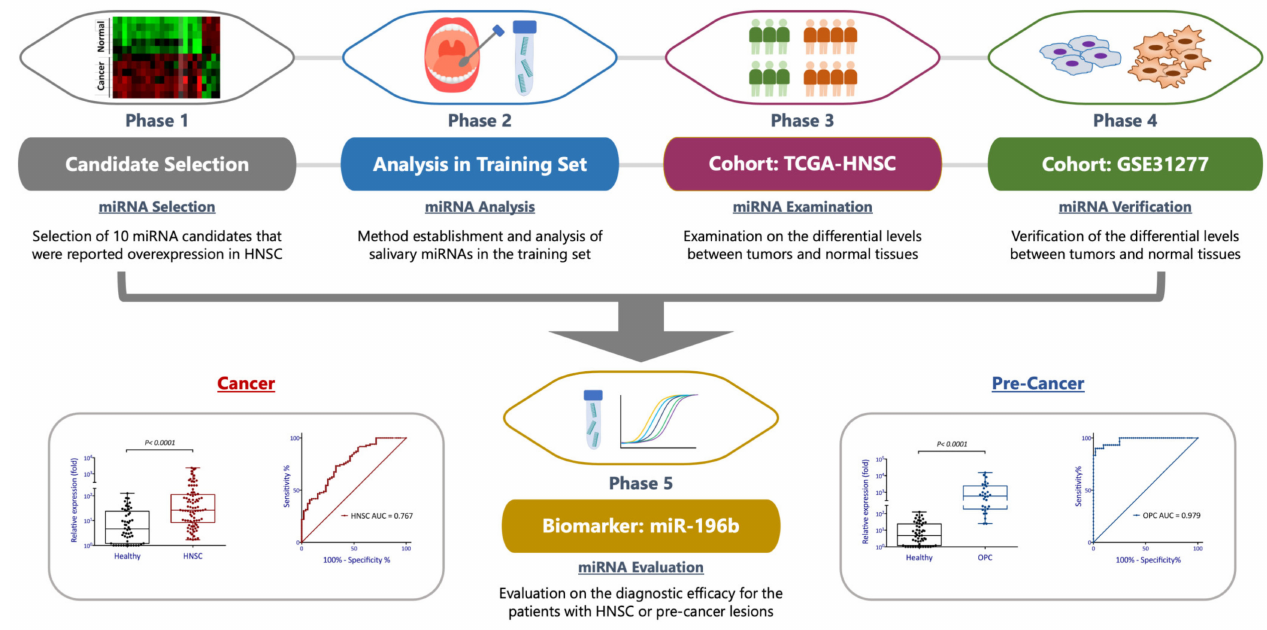
Figure 1. Flow diagram representing the systemic strategy and research design to discover an effective salivary biomarker for early detection of patients with head-neck